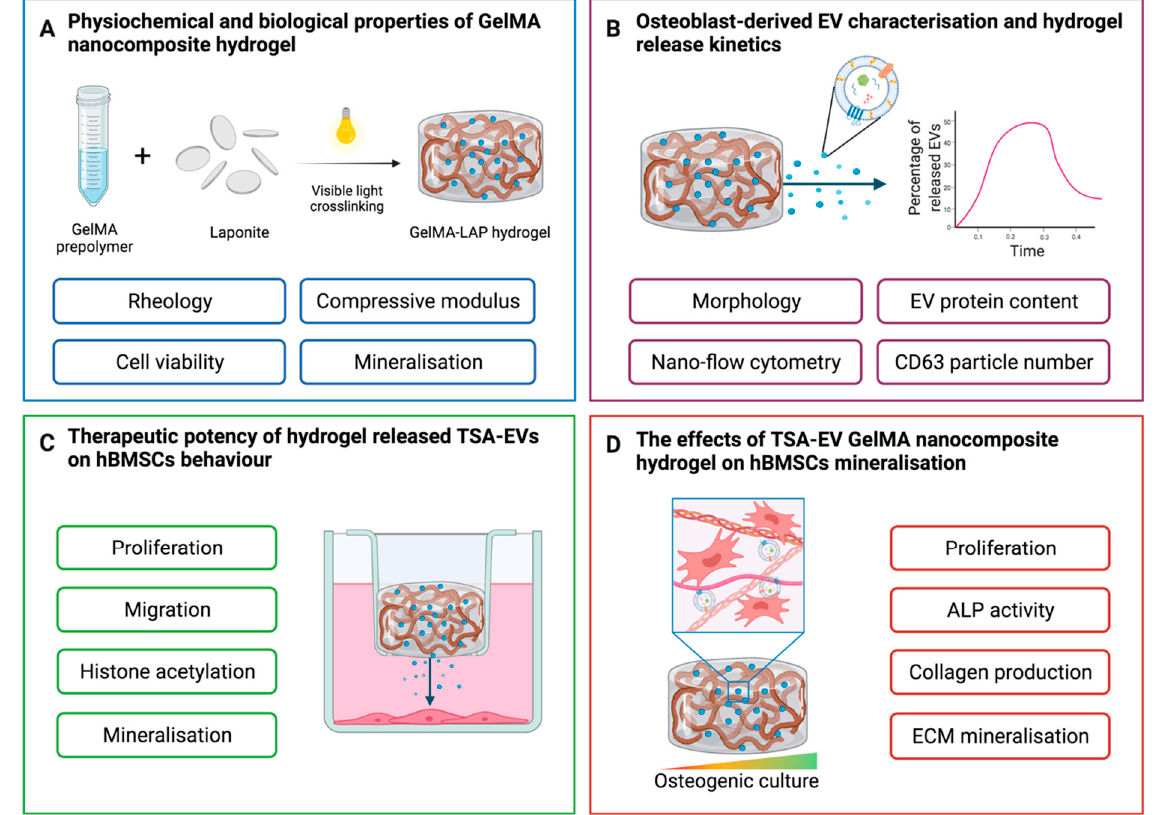
Figure 1. Experimental outline detailing the osteoinductive potency of epigenetically-modified EVs loaded GelMA nanocomposite hydrogel. ( A ) The physiological and biological effects of the GelMA nanocomposite hydrogel was investigated. ( B ) EV isolation, characterisation, and hydrogel-EV release kinetics was assessed. ( C ) The biological efficacy of hydrogel-released EVs on hBMSCs behaviour. ( D ) The influence of TSA-EV functionalised hydrogel on encapsulated hBMSCs mineralisation. Created with BioRender.com (last accessed 13 December 2021).